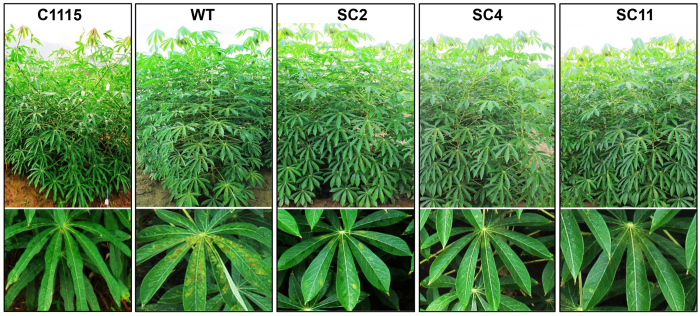
The damaged situtation in different cassava plants in the field.The bottom panels showed individual leaves. WT and C1115 were used as the mite-susceptible control and the mite-resistant control, respectively.